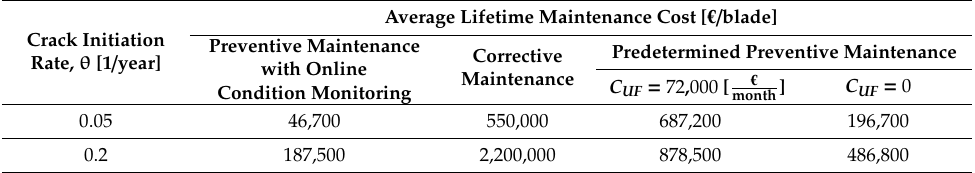
Table 3. Summary of the average lifetime maintenance cost for di ff erent maintenance